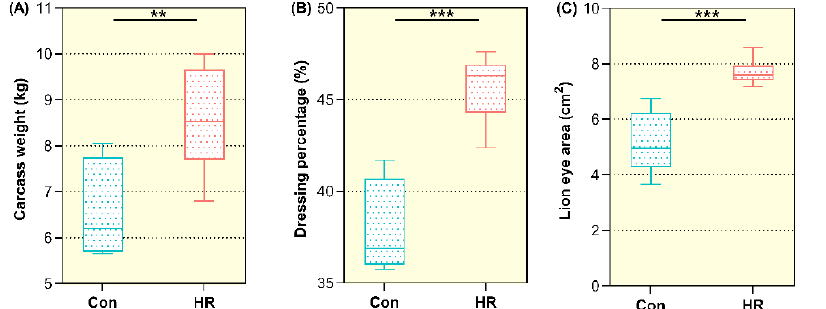
Figure 1. The slaughtering characteristic of growing goats fed the control and high-rice diet. Con, control diet; HR, high-rice diet. ( A ) The carcass weight of goats between control and high-rice diet. ( B ) The dressing percentage of goats between control and high-rice diet. ( C ) The loin eye area of goats between control and high-rice diet. “**” means that the difference between the two groups is significant ( p < 0.05), and “***” means that the difference between the two groups is extremely different ( p <